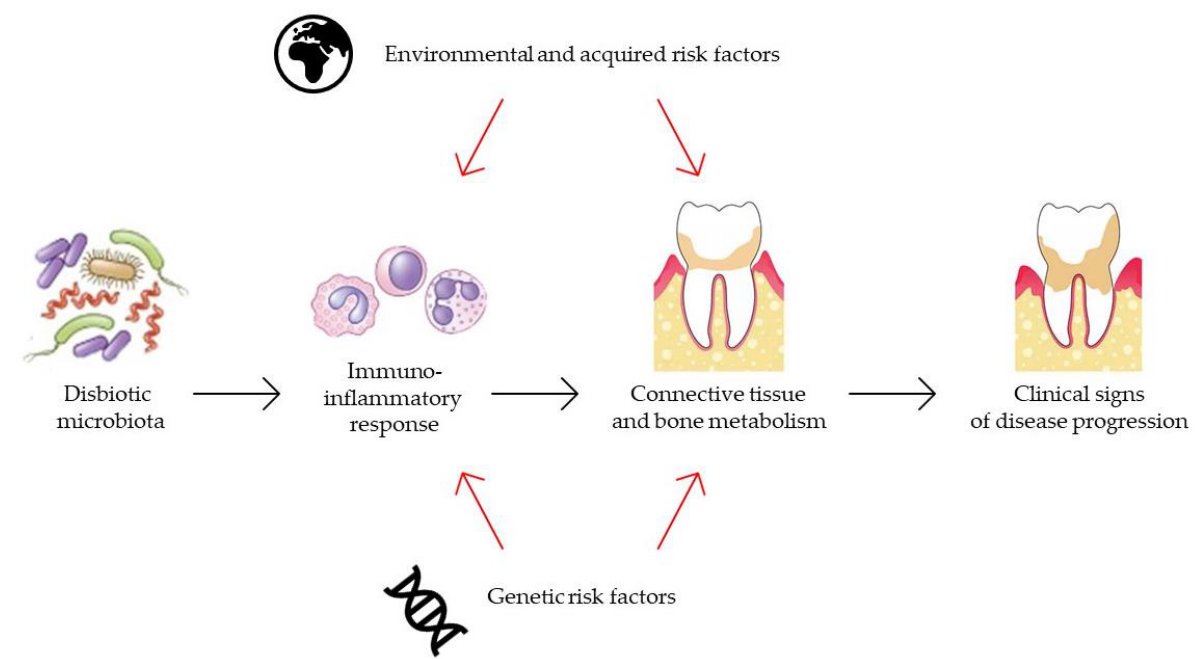
Figure 1. Model of pathogenesis of periodontitis.